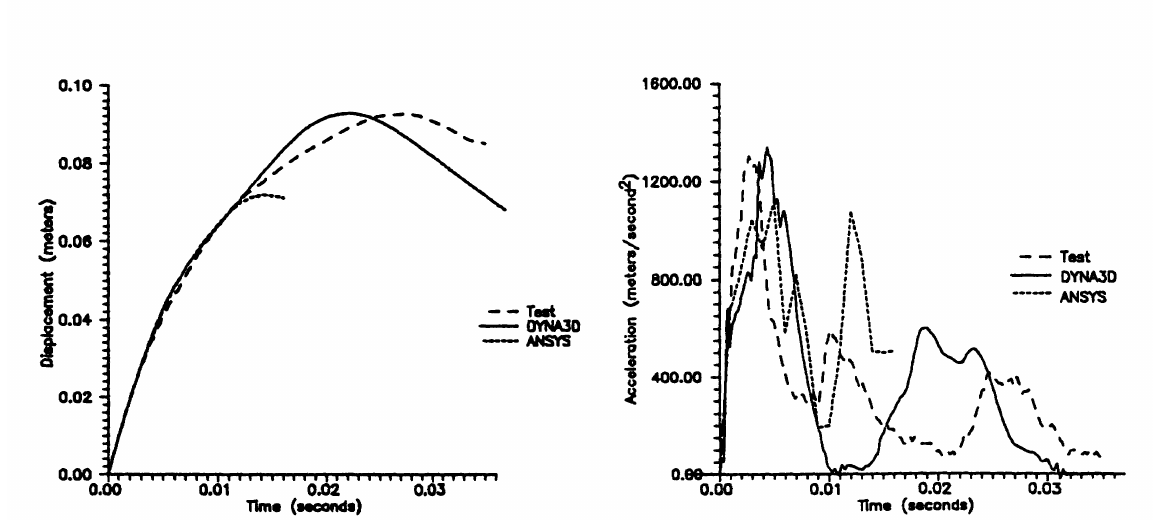
FIGURE 5 Ciera central hood: head form displacement and